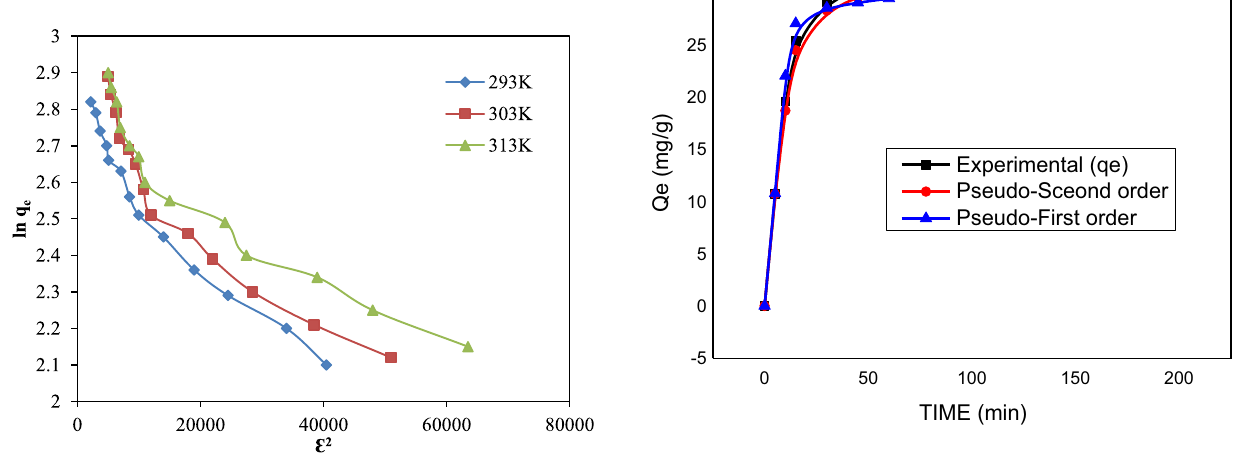
Fig. 11 Plot for D–R isotherm at 293 K, 303 K and 313 K